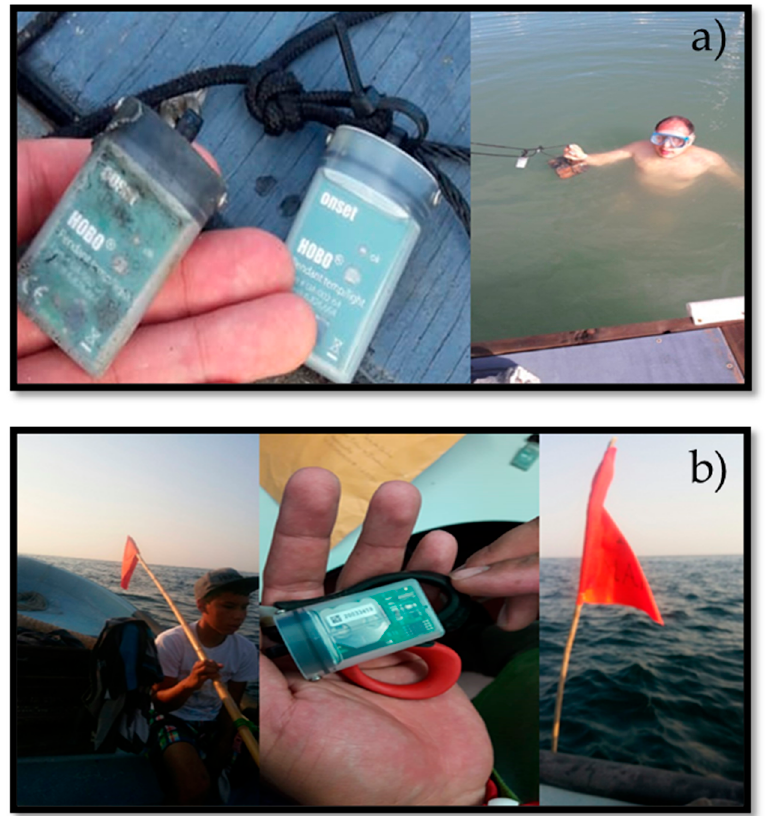
Figure 3. Colocation of the thermistors in ( a ) Marina Cruz de Huanacaxtle and ( b ) La Mina.